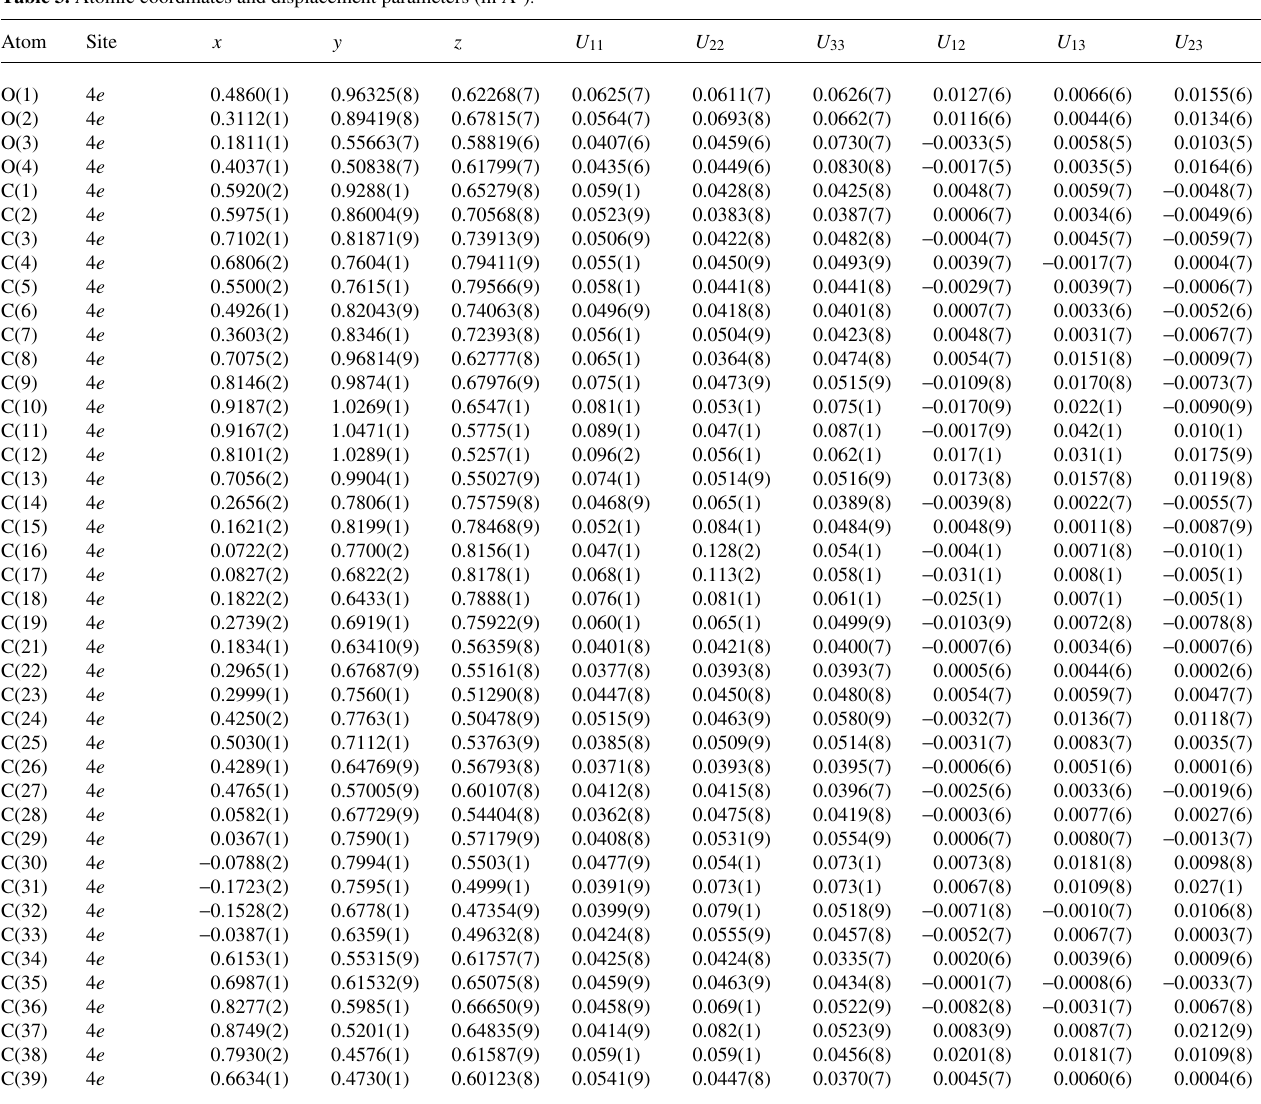
Table 3. Atomic coordinates and displacement parameters (in Å 2 ) .